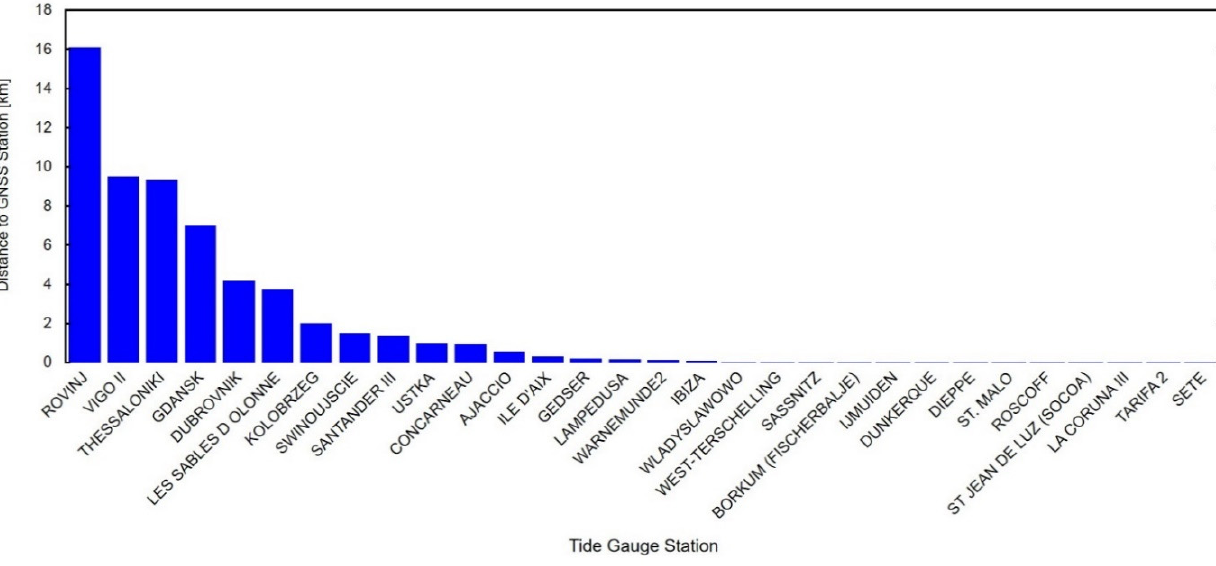
distance from the nearest TG ranged from 0.002 km to 16.069 km (Figure 6).